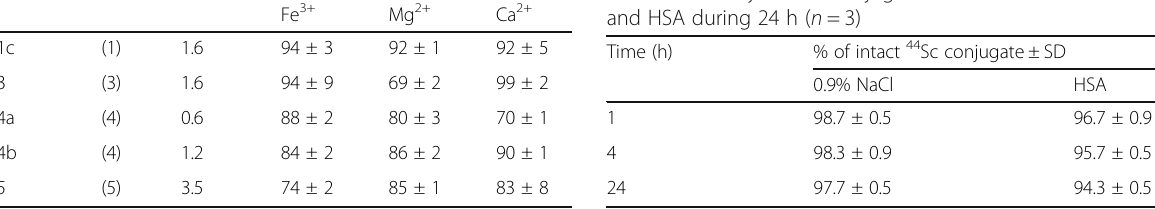
Table 6 Stability of 44 Sc conjugate 31c at 37 °C in 0.9%